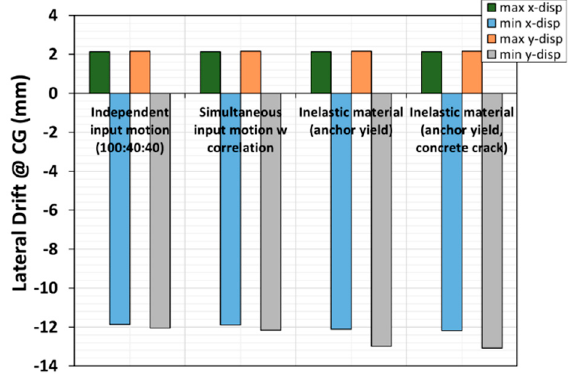
Figure 22. Lateral drift at the center of gravity (M24, dynamic analyses).